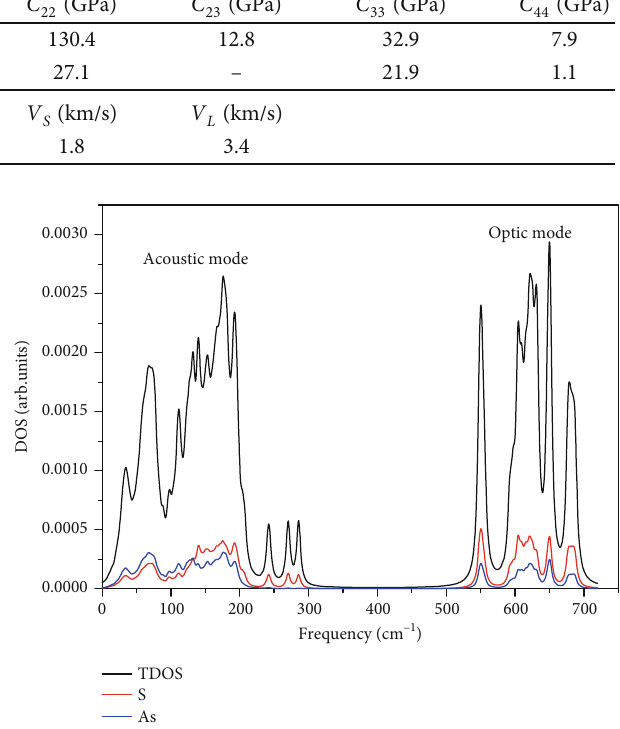
S under pressure. 2 3 Figure 6: The partial density of states (PDOS) and total phonon density of states (TDOS) of orpiment As